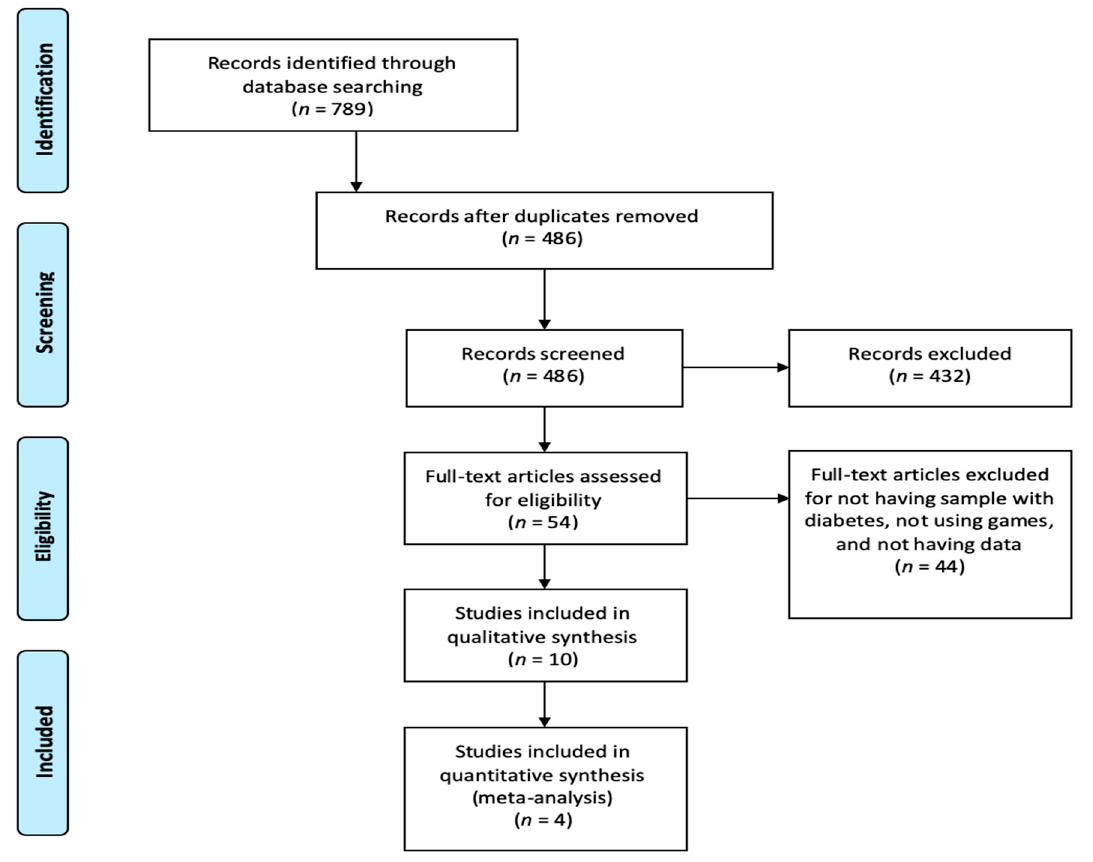
Figure 1. Prisma flow diagram of study selections.